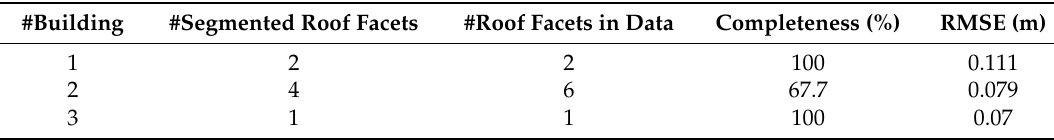
Table 5. Completeness and accuracy of facade segmentation.